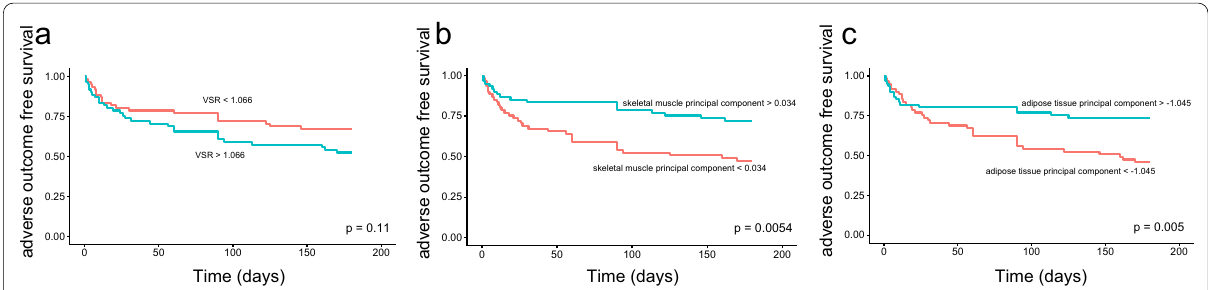
Fig. 5 Adverse outcome free survival. Kaplan–Meier curves depicting adverse outcome free survival for the overall population stratified by VSR ( a ), skeletal muscle principal component ( b ), and adipose tissue principal component ( c ). VSR area of visceral fat/area of subcutaneous fat